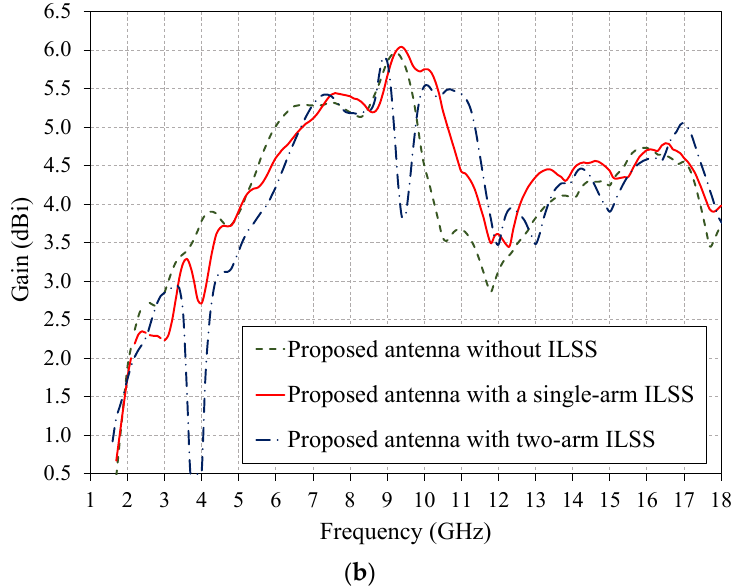
Figure 3. Simulated |S 11 | and gain of the proposed antenna with and without ILSS: ( a ) |S 11 | and ( b ) Gain.